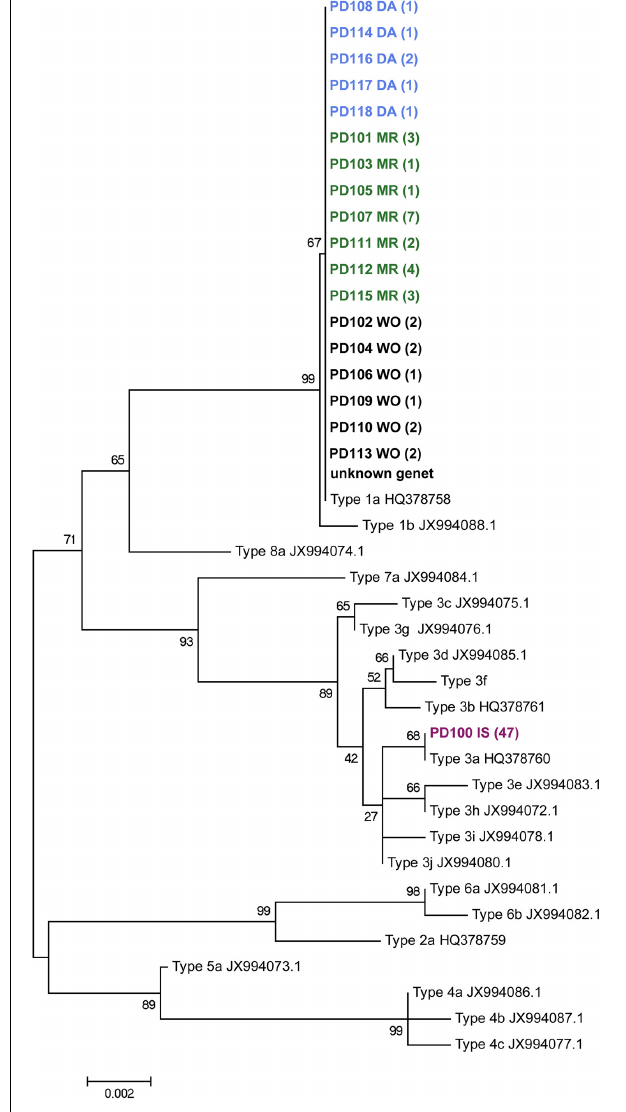
FIGURE 2 | Neighbor-joining phylogenetic tree of the Pocillopora mtDNA open reading frame of unknown function . Each genet (names begin with letters PD) was included once in this dataset. Each genet name includes its geographic location as the last two letters, with “DA” = Darwin, “MR” = Marchena, “WO” = Wolf, “IS” = Isabela. The number of times a genet was observed is indicated in parentheses. Genet PD 119 failed to amplify for this marker. The topology of the tree matches the one published by Pinzón et al. (2013), however Type 4 clusters with Type 5 here rather than with Types 3 and 7. Pinzon et al. reported clustering of Type 4 with Type 5 in their Structure analysis. Gene Bank accession